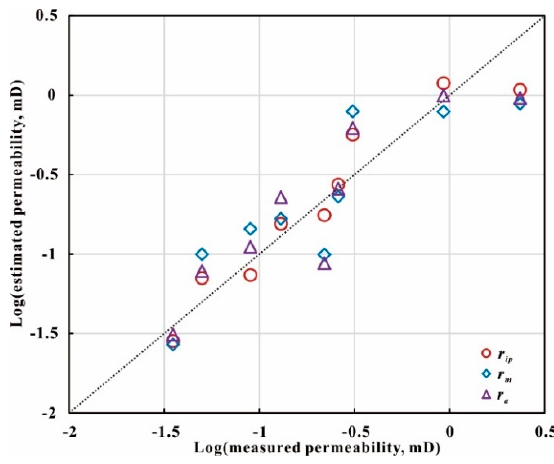
Figure 20. Measured permeability versus estimated permeability using r ip , r m , and r a , respectively. The 1:1 line (black dashed line) exhibits the perfect match.